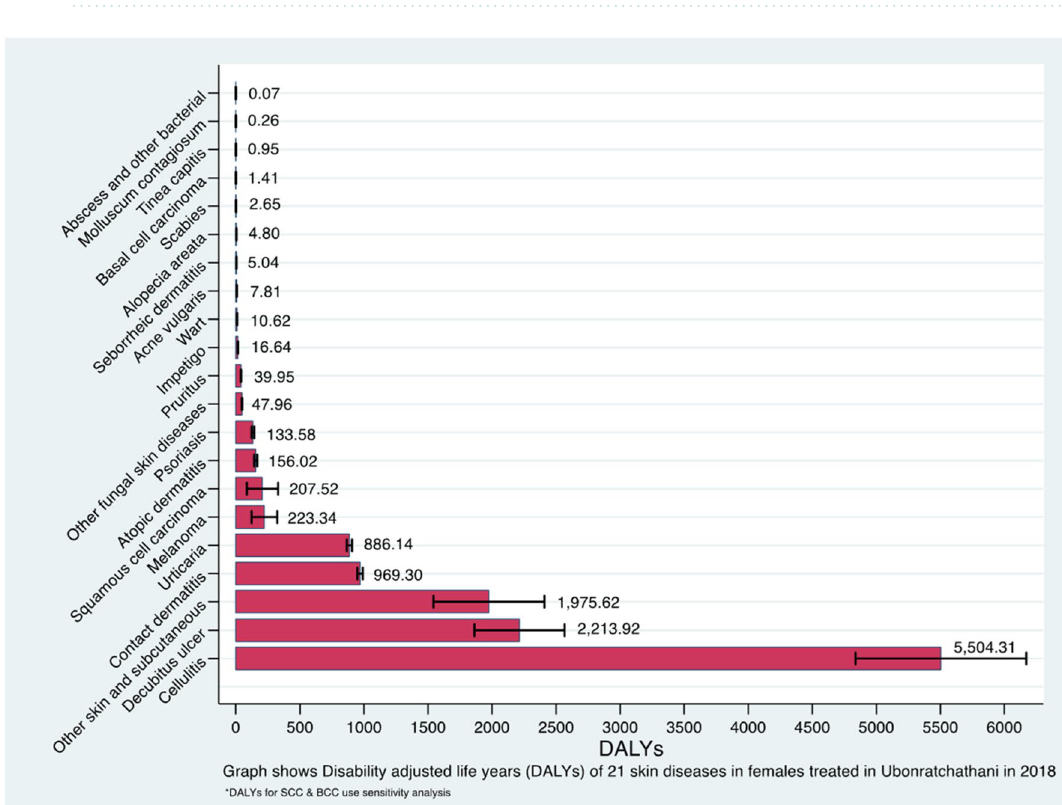
Figure 3. DALYs due to different skin diseases in females (in ascending